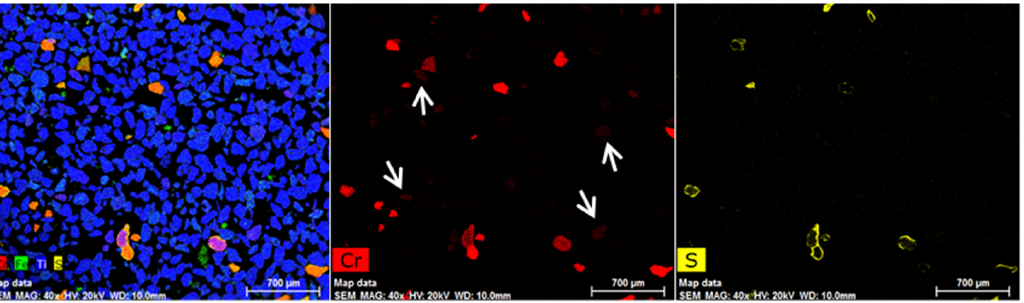
Figure 15. EDX mapping of sample‒DM‒1 after the demetallisation with H 2 SO 4 .